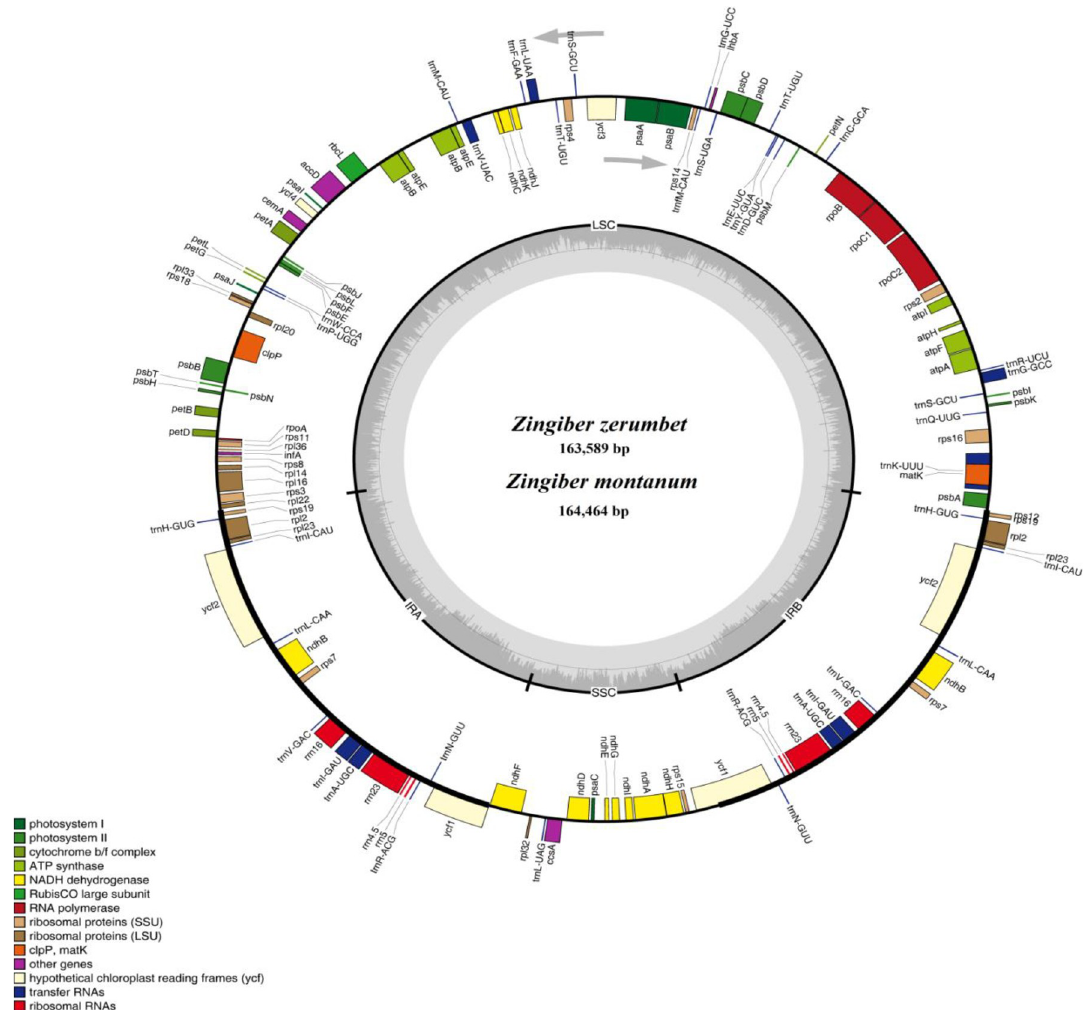
Fig 1. Circular gene map of the chloroplast genomes of two Zingiber species. The gray arrowheads indicate the direction of the genes. Genes shown inside the circle are transcribed clockwise, and those outside the circle are transcribed counterclockwise. Different genes are color coded. The innermost darker gray corresponds to GC content, whereas the lighter gray corresponds to AT content. IR, inverted repeat; LSC, large single copy region; SSC, small single copy region.